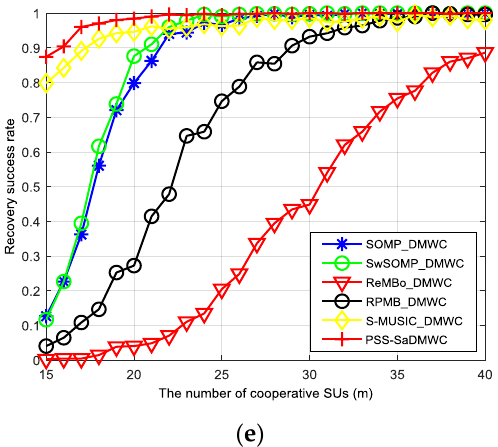
Figure 10. Reconstruction performance comparison between the PSS-SaDMWC and other existing single selection schemes. ( a ) SNR = 0 dB; ( b ) SNR = 5 dB; ( c ) SNR = 10 dB; ( d ) SNR = 15 dB; ( e ) SNR = 20 dB.